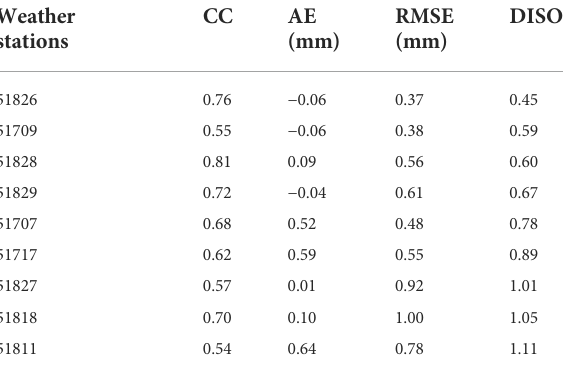
TABLE 3 Distance between Indices of Simulation and Observation (DISO) for GPM data and meteorological station observations. Weather